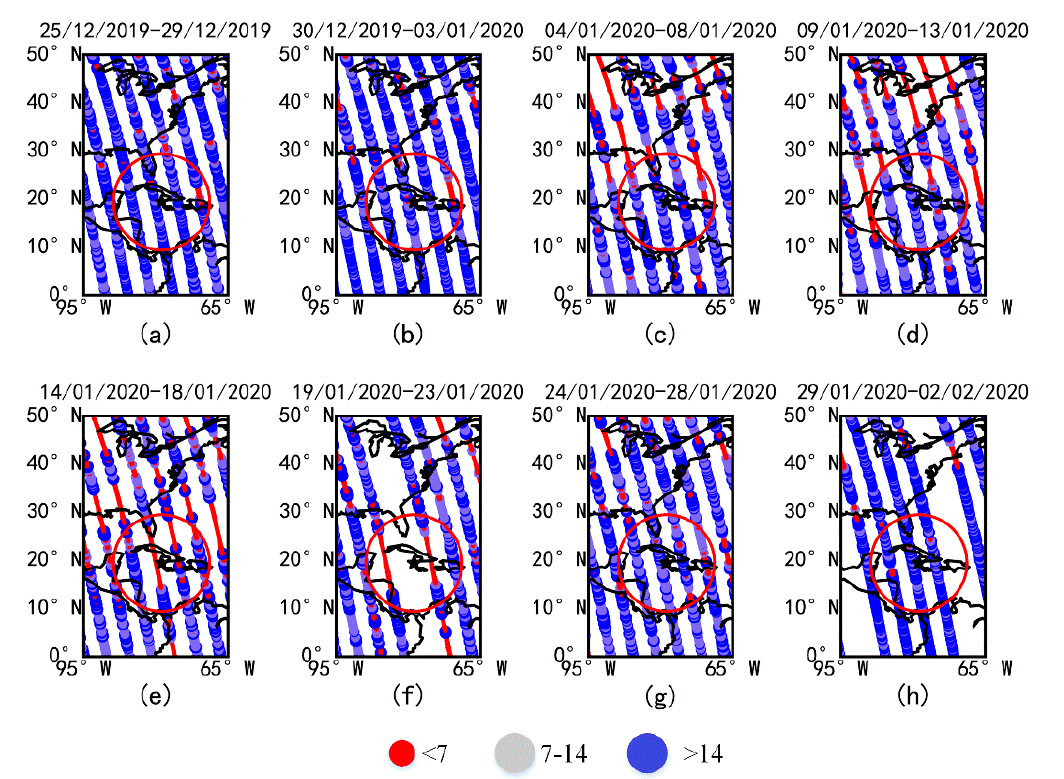
Figure 3. The space ‐ time diagram of the electric field SNR over the NAA transmitting station ob ‐ served by the CSES (The eight subplots( a – h ) in Figure 3 represent a total of eight cycles from 25 December 2019, while the satellite operates every five days to 2 February 2020. The black star indi ‐ cates the location of the epicenter, and the red circles indicate the seismogenic zone).